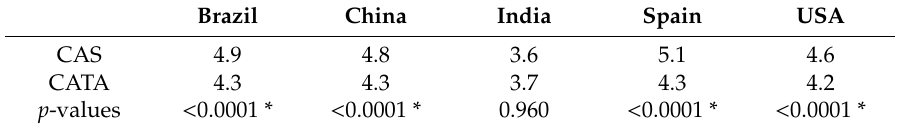
Table 8. Means † and p -values for just about right ratings for CAS and CATA per country.